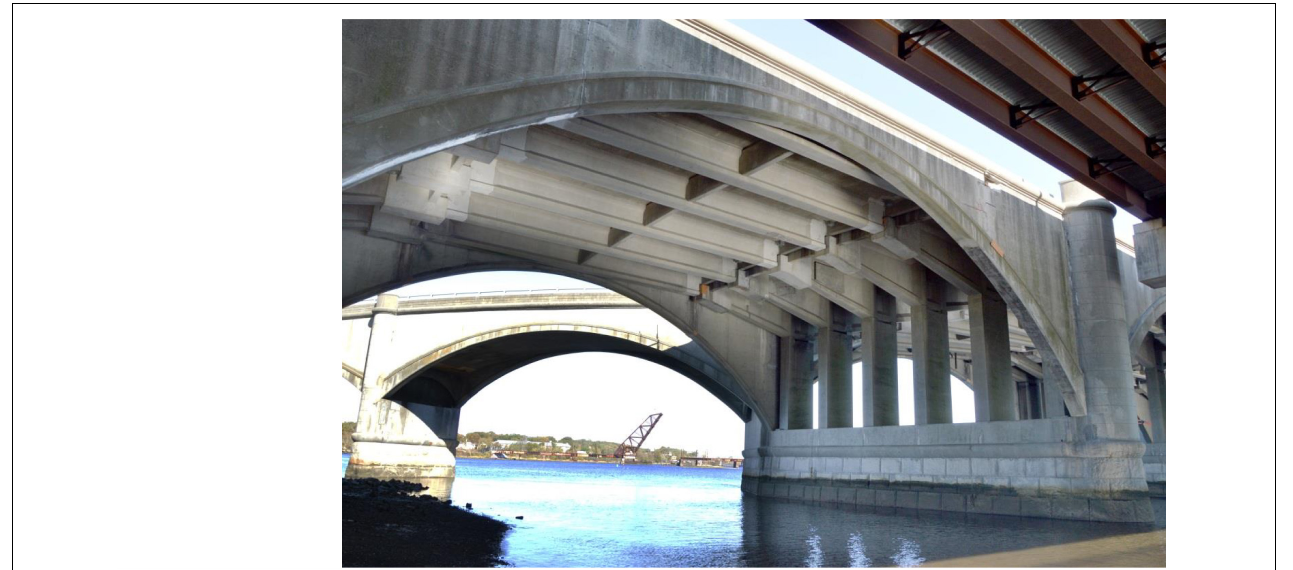
FIGURE 2 | Dapped end of drop-in girder supported by cantilevered girder section from pier.